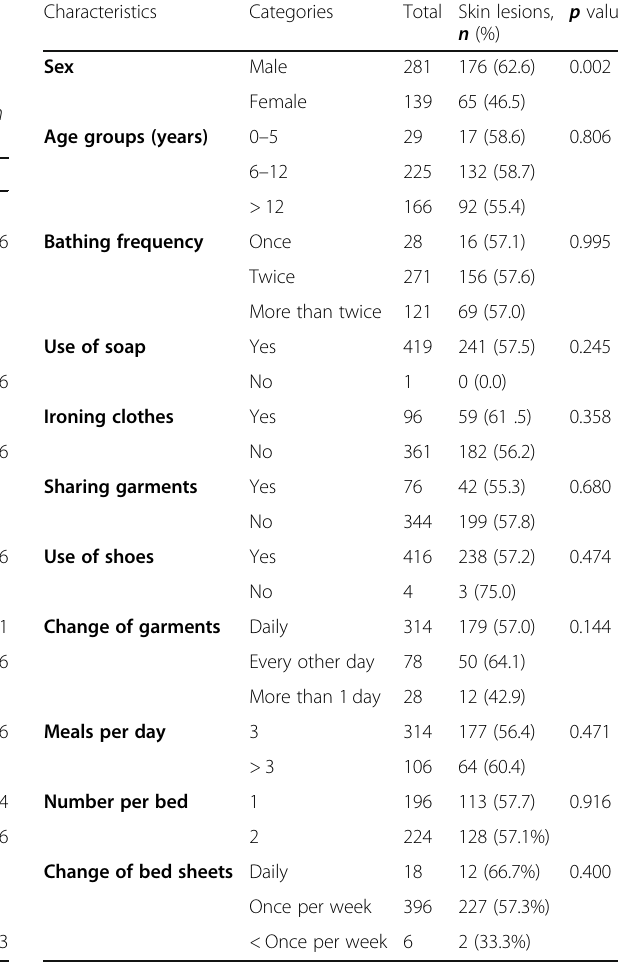
Table 4 Factors associated with dermatological conditions among children living in orphanage centres in Dar es